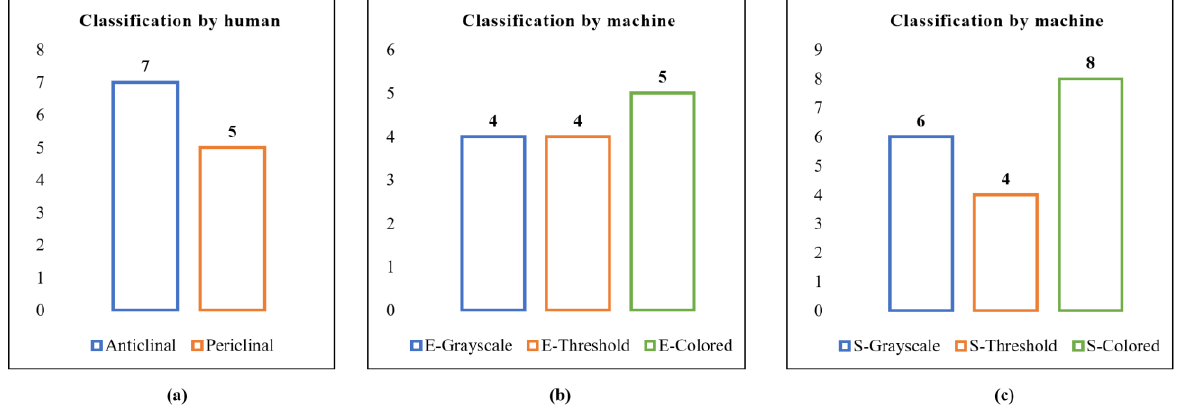
Figure 11. ( a ) Original number of clusters generated by humans. ( b ) Number of clusters generated using the Elbow method. ( c ) Number of clusters generated using the Silhouette method.